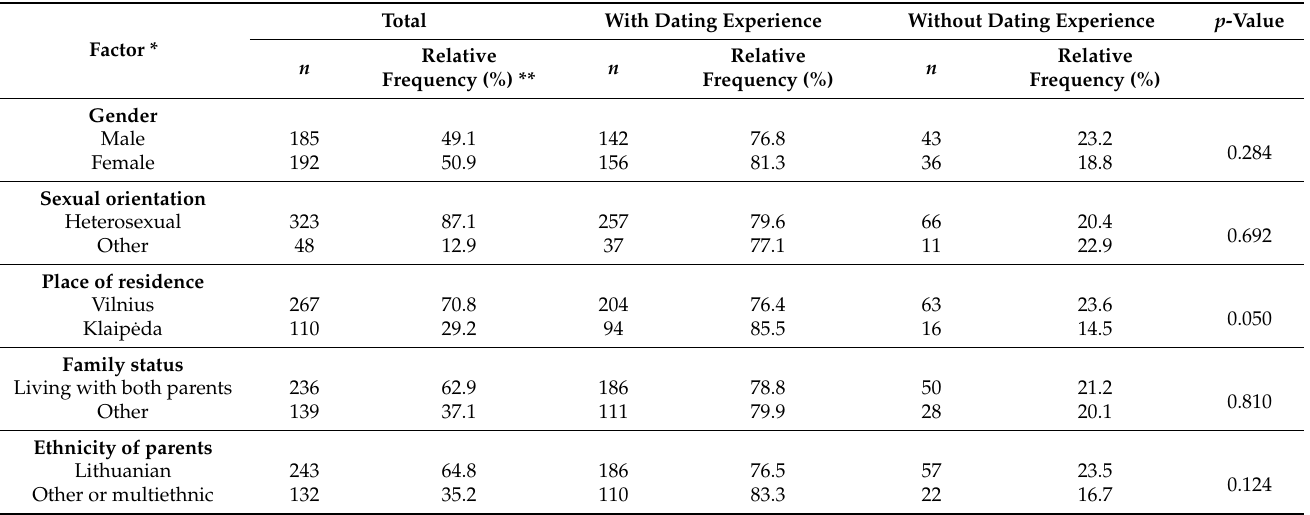
Table 1. Distribution of the respondents regarding the presence of dating experience and sociodemo- graphic